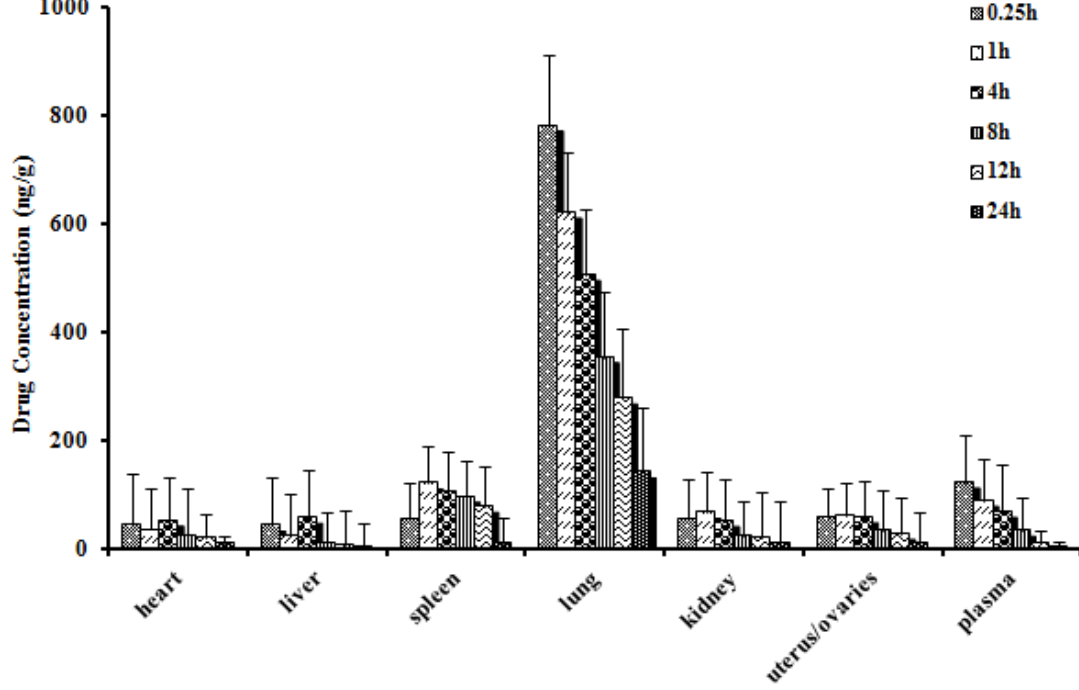
Figure 6. Distribution in tissue in mice after following i.v. administration of a single 5 mg/kg dose of DTX-loaded microspheres tissues (ng/g) and plasma (ng/mL), (Each point represents the mean ± SD of 5